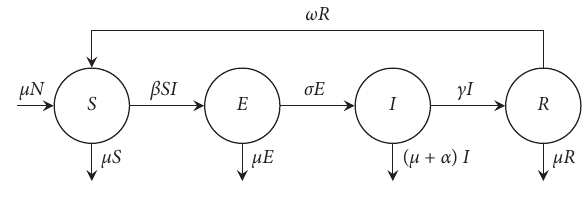
Figure 2: SEIRS model flow Table 1: Parameters of the SEIRS model.